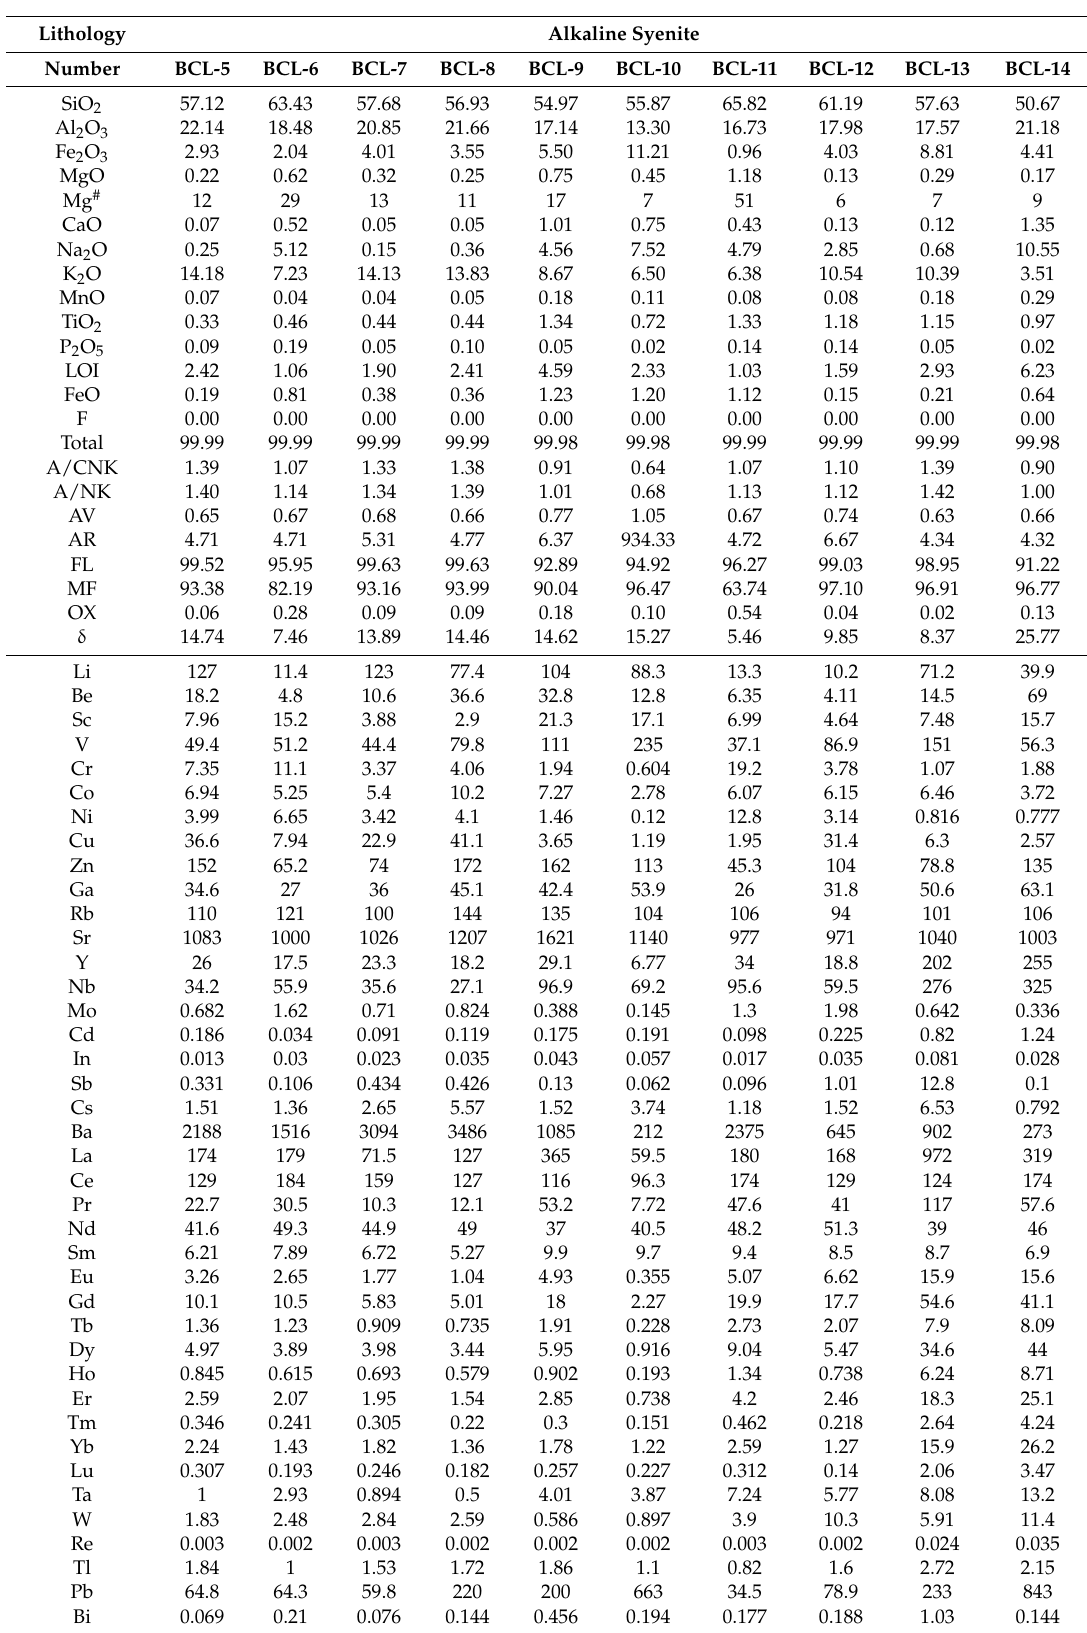
Table 4. Whole rock analyses of the major (wt.%) and trace (ppm) elemental compositions of the